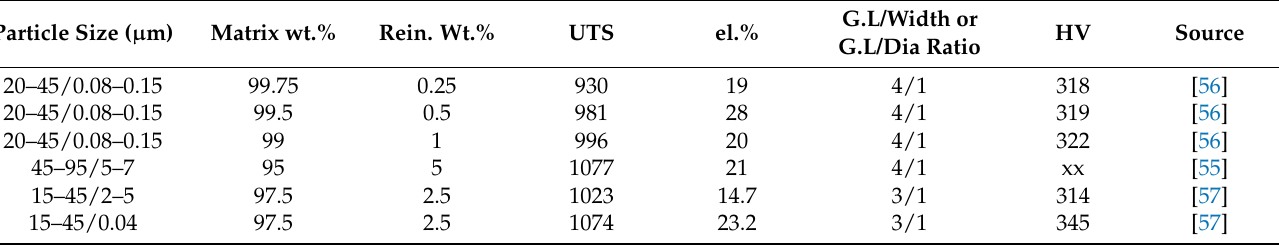
Table A1. TiC reinforced IN625-based composites by DLD (Reference sources for Figure 3). Particle Size ( µ m) Matrix wt.% Rein.